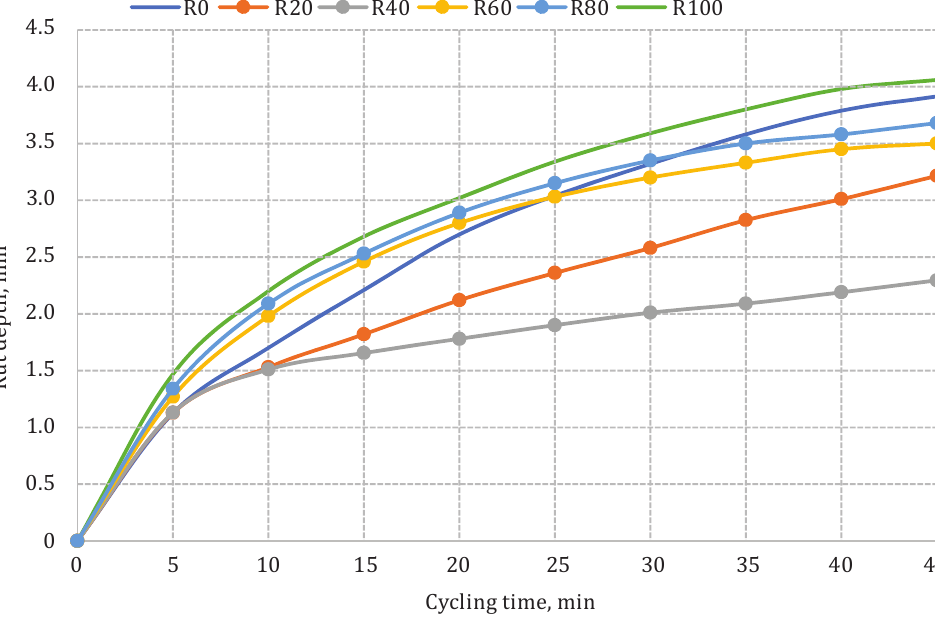
Figure 5. Rutting resistance of the